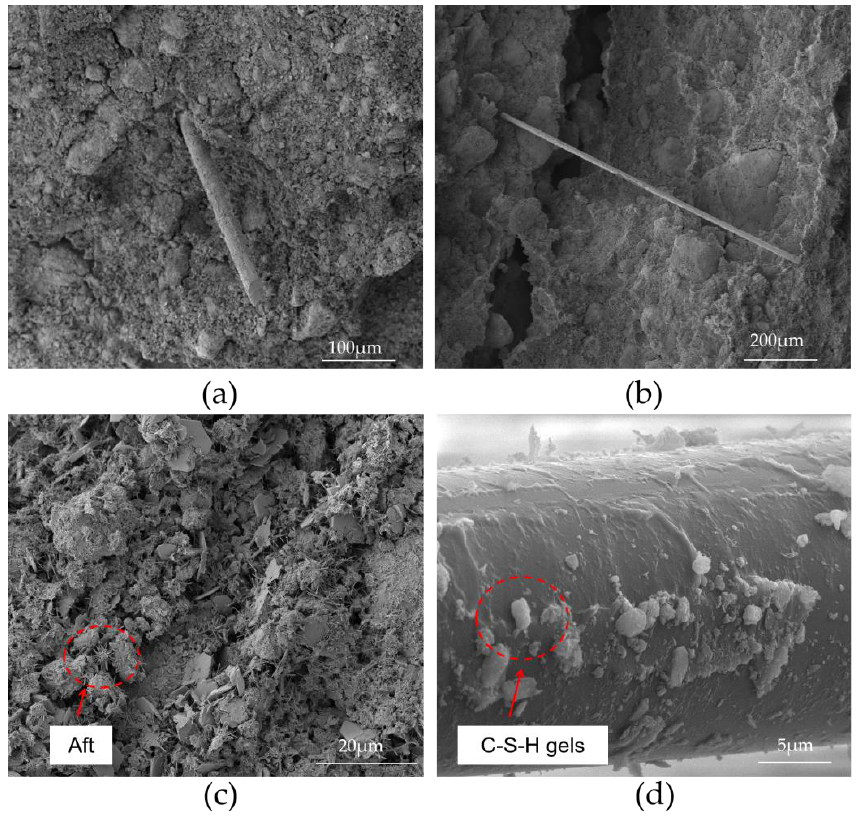
Figure 10. SEM images of typical specimens: ( a ) typical cross-section of a BFBCP; ( b ) fiber bridging; ( c ) Aft; ( d ) C-S-H gels.